Question: What does this figure show? Answer in one sentence.
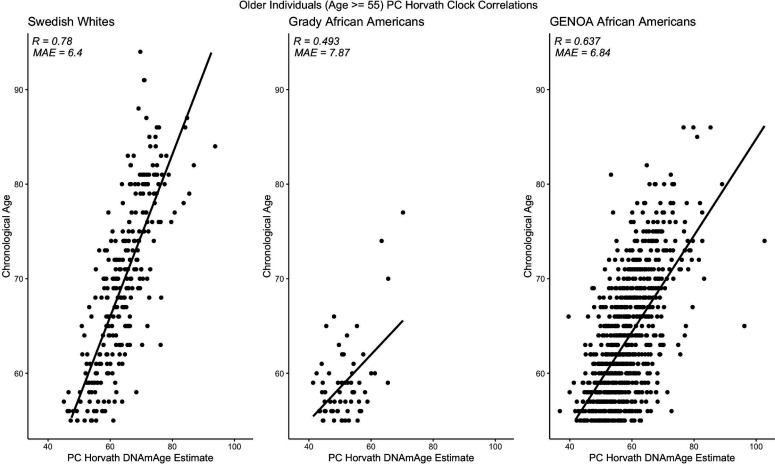
Answer: Lower methylation clock accuracy in African Americans holds across cohorts. Scatter plots of chronological age versus Horvath DNAm age in three independent replication cohorts: Swedish Whites (NSPHS), GENOA Study African Americans, and Grady Trauma Project African Americans. Top Row: Age predictions for the full age range of each cohort. The Swedish White cohort exhibits the highest accuracy ( r = 0.97 \begin{document}$r=0.97$\end{document} , MAE = 3.04), while both African American cohorts show lower correlations ( r = 0.85 \begin{document}$r=0.85$\end{document} and r = 0.88 \begin{document}$r=0.88$\end{document} ) and higher error rates (MAE = 3.83 and 5.14, respectively). Bottom Row: Age predictions restricted to individuals ≥55 years old, similar to the demographics of the MAGENTA cohorts. In this age-restricted subset, the disparity in clock performance is consistent, with the Swedish White cohort maintaining a significantly higher correlation ( r = 0.80 \begin{document}$r=0.80$\end{document} ) compared to the GENOA ( r = 0.67 \begin{document}$r=0.67$\end{document} ) and Grady ( r = 0.49 \begin{document}$r=0.49$\end{document} ) African American cohorts.